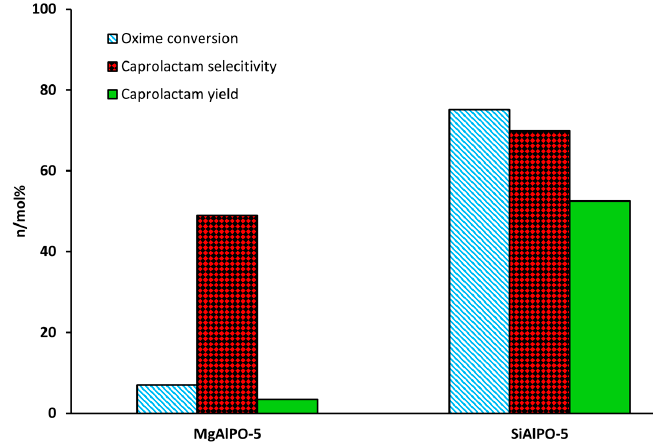
Figure 4. Activity of Mg- and Si-doped AlPO-5 in the vapour-phase Beckmann rearrangement of cyclohexanone oxime (WHSV 3.3 h − 1 , He carrier gas 20 mL min − 1 , 0.3 g catalyst, liquid feed 300 g L − 1